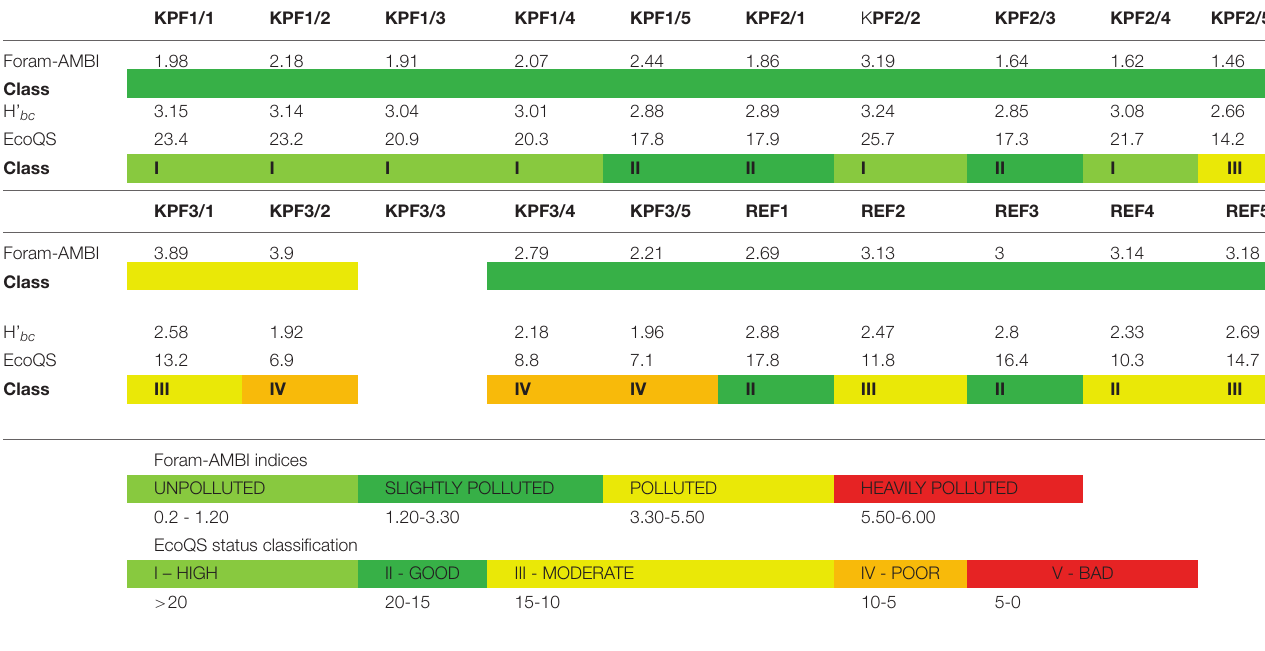
TABLE 4 | Foram-AMBI indices and ecological quality statuses EcoQS at each studied interval obtained from the study of total